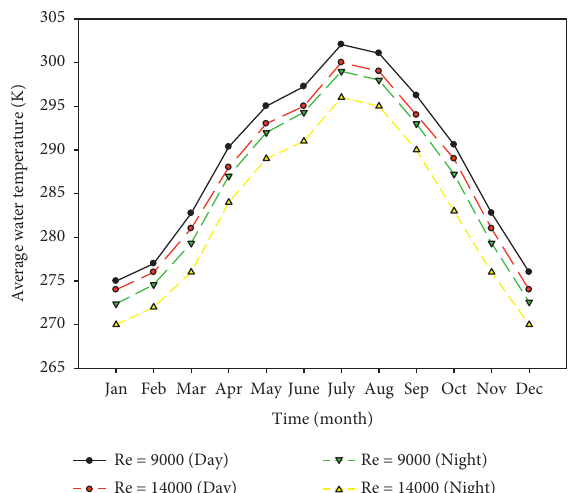
Figure 10: Effect of Re on average water temperature for reactor inclined at 1 ° , water depth � 5.6 mm, and aspect ratio �